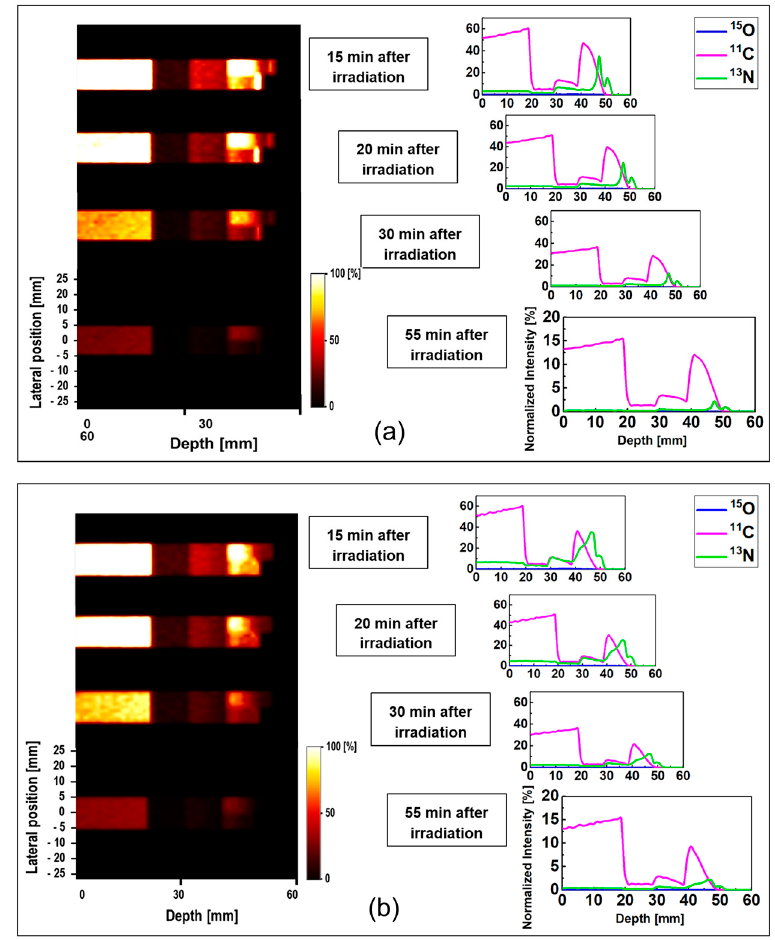
Figure 6. The 2D and 1D time-course activity analysis in the time range of 15 to 55 min for 15 O, 11 C, and 13 N positron emitting radionuclides in the ordinary slab phantom irradiated with ( a ) pristine and ( b ) SOBP beams.